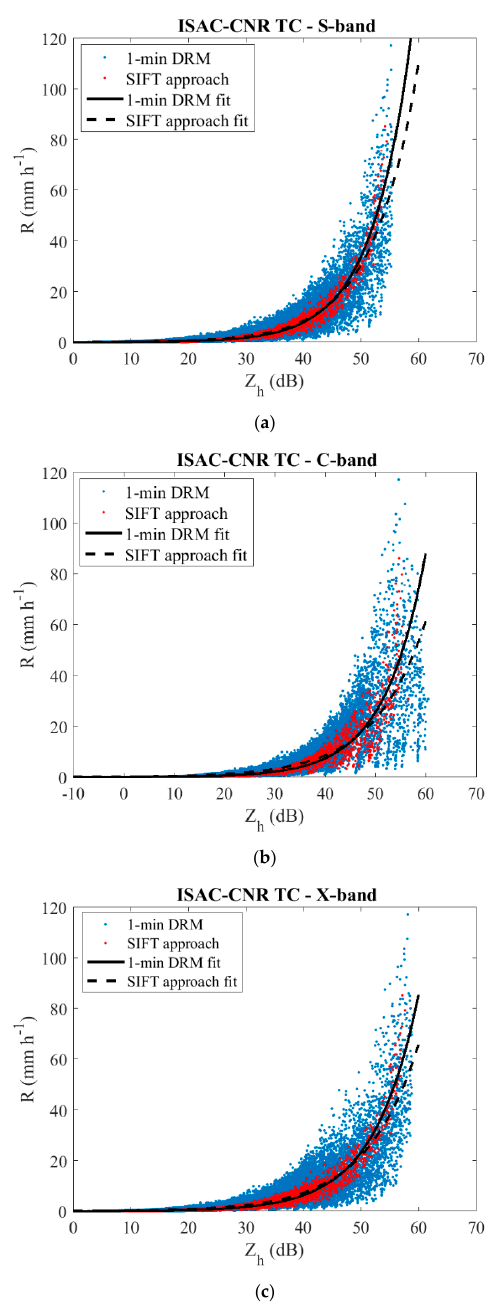
Figure 6. Scatterplot of Z versus R as obtained from Thies Clima DSDs for the different frequencies considered in this study. Blue dots are for 1-min DRM and red dots are for the SIFT approach. The black lines represent the Z - R relation obtained from 1-min DRM and applying SIFT. ( a ) S-band; ( b ) C-band; ( c ) X-band.